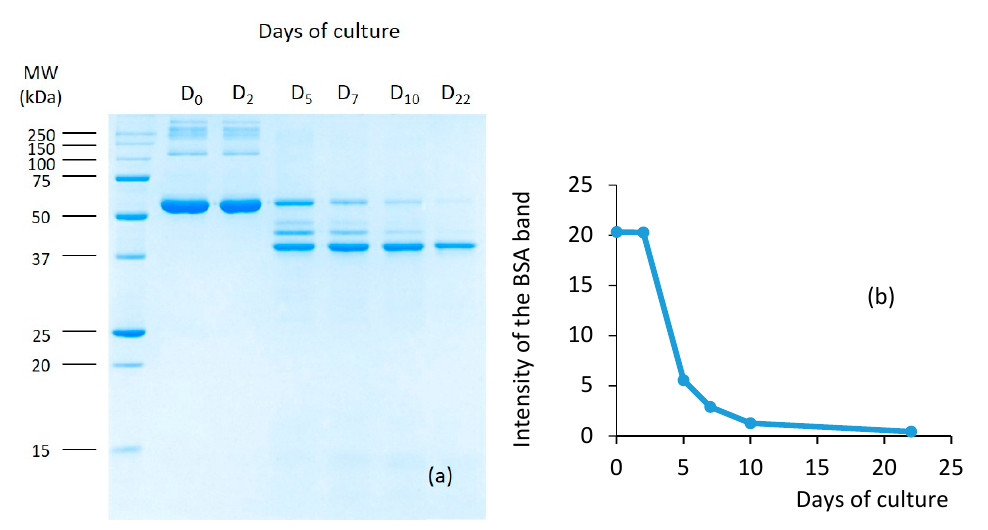
Figure 2. Protease activity on BSA as monitored by SDS-PAGE. ( a ) BSA was incubated for 10 min at 30 °C with the supernatant of Botrytis cinerea after 0 to 22 days of culture. Relative MWs (×10 − 3 ) of the protein standards are given on the left side of the gel. Proteins were stained by CBB. ( b ) Densitometric integration of the native BSA band (the intensities of the bands are expressed by the arbitrary units given by the Bio-Rad integrator).